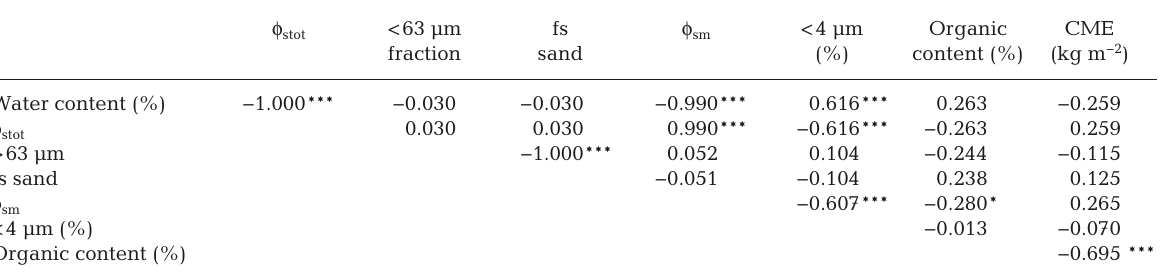
Table 8. Navy Island. As in Table 7, but for Navy Island